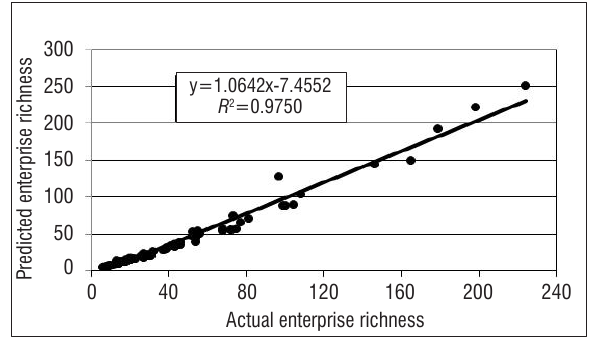
Figure 4: Enterprise richness in Free State settlements predicted by the 1946/47 power law versus actual enterprise richness measurements for 2012/2013.